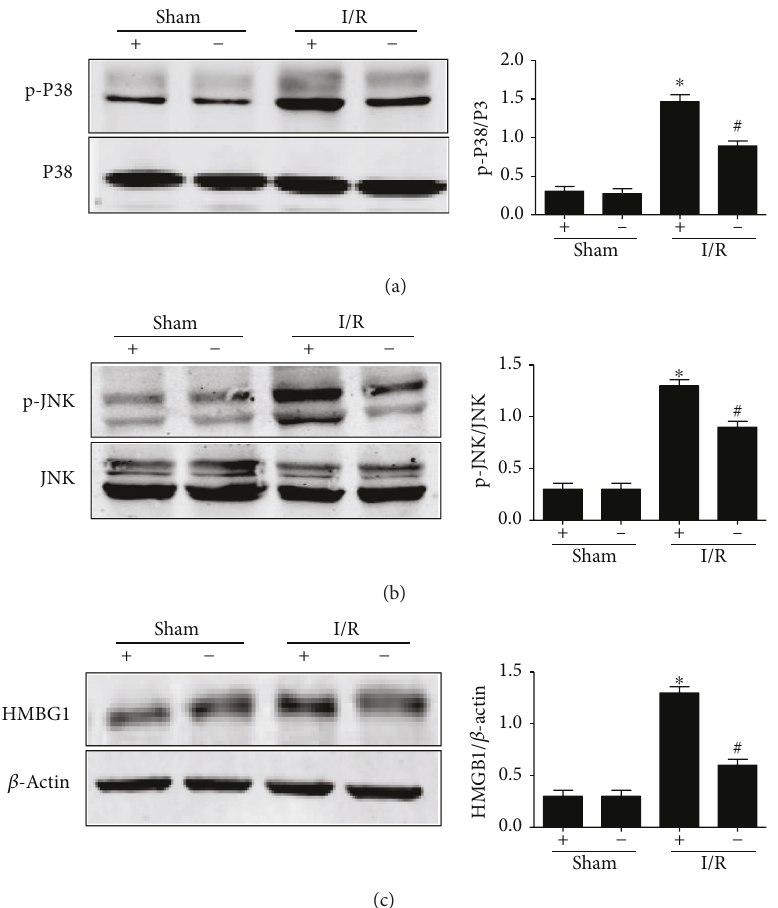
Figure 7: HMGB1 and p-P38/JNK were markedly attenuated in the lung tissues in TLR4-targeted mice. Lung homogenates of all groups extracted the proteins to check the phosphorylation of P38 (a) and JNK (b); HMGB1 level was also checked (c). GraphPad values are presented as mean ± SEM. ∗ P < 0 05 versus the Sham group; # P < 0 05 compared to the liver warm I/R